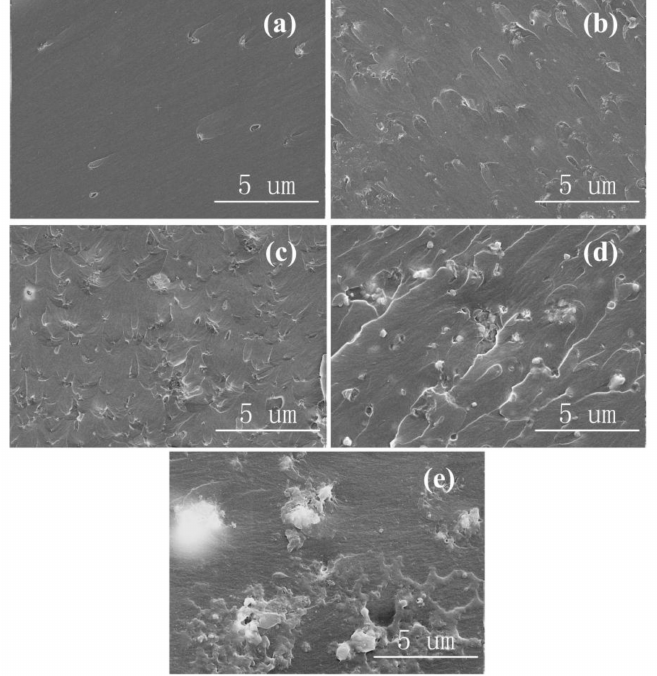
Figure 2. SEM images of Al 2 O 3 -NWs / epoxy resin composites with di ff erent mass ratios: ( a ) 1 wt%; ( b ) 3 wt%; ( c ) 5 wt%; ( d ) 7 wt%; and ( e ) 10